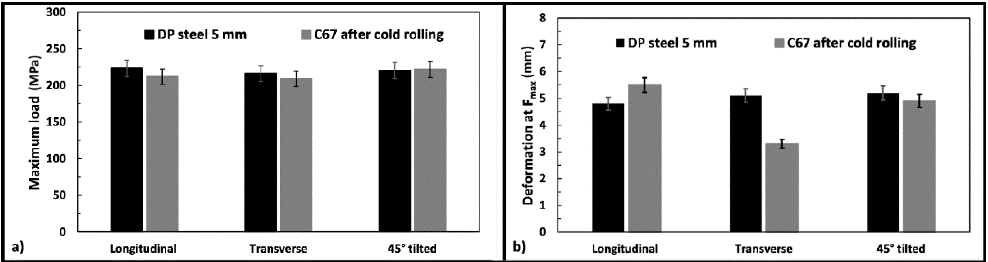
Figure 9. Averaged data from all the bending tests: maximum load measured ( a ) and maximum deformation observed ( b ), respectively.